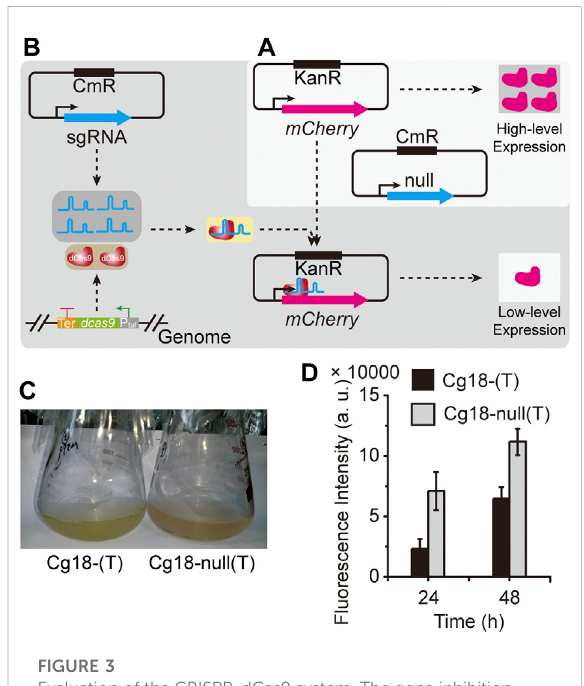
Evaluation of the CRISPR-dCas9 system. The gene inhibition ability of CRISPR-dCas9 system was evaluated through the expression intensity of mCherry protein. (A) The high-level expression of mCherry gene. (B) The CRISPR-dCas9 system was used to inhibit mCherry gene expression. (C) The strains with mCherry gene expression plasmids; the strain Cg18-(T) harbored pXM-sgRNAi- mCherry (T) and pNCgl1676- mCherry ; the strain Cg18-null(T) harbored pXM-sgRNAi-Null and pNCgl1676- mCherry . (D) The Fluorescence intensity of the strains harboring mCherry gene expression plasmids. Error bars are standard deviation of triplicate